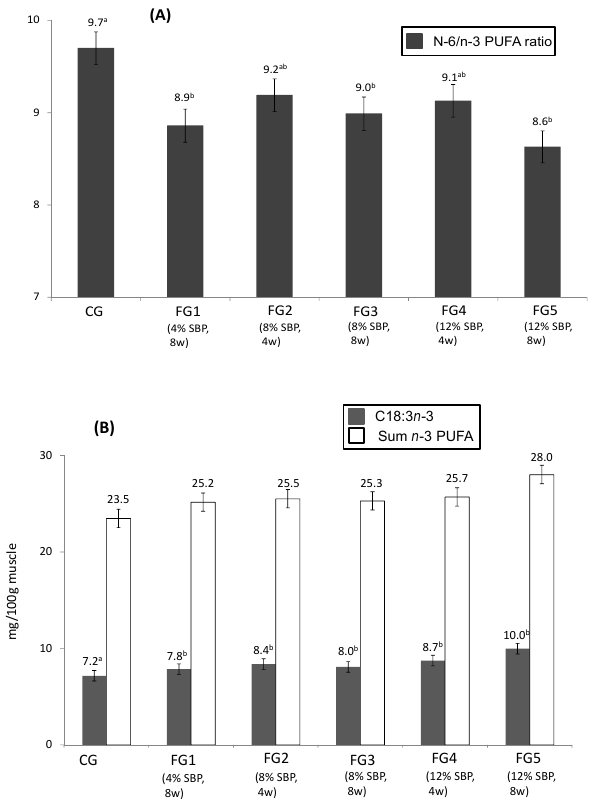
Figure 1. n -6 /n -3 PUFA ratio (a) , ALA and the sum of n -3 fatty acid concentrations (mg/100g) of longissimus muscle (b) of pigs whose diets were supplemented with sea buckthorn pomace (LSM ± SEM; a, b – significant differences at P ≤ 0 . 05).